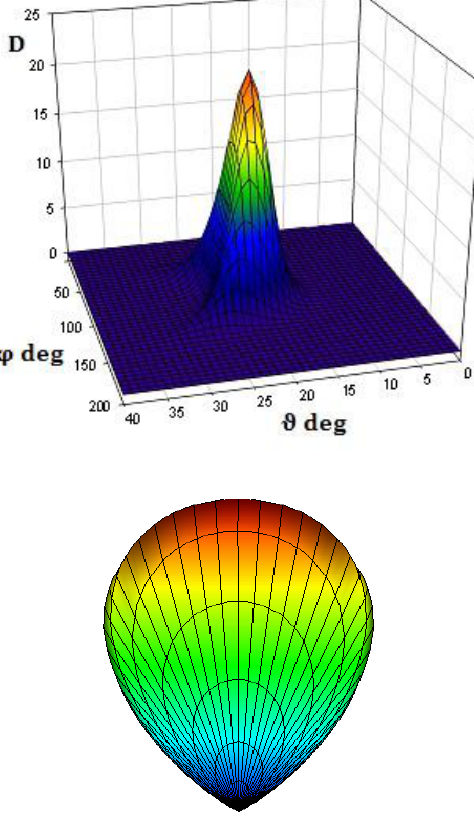
Figure 5a: The incident field